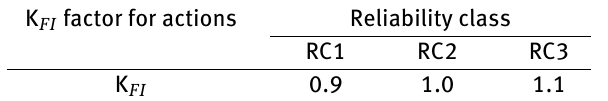
Table 2: K FI factor for actions K FI factor for